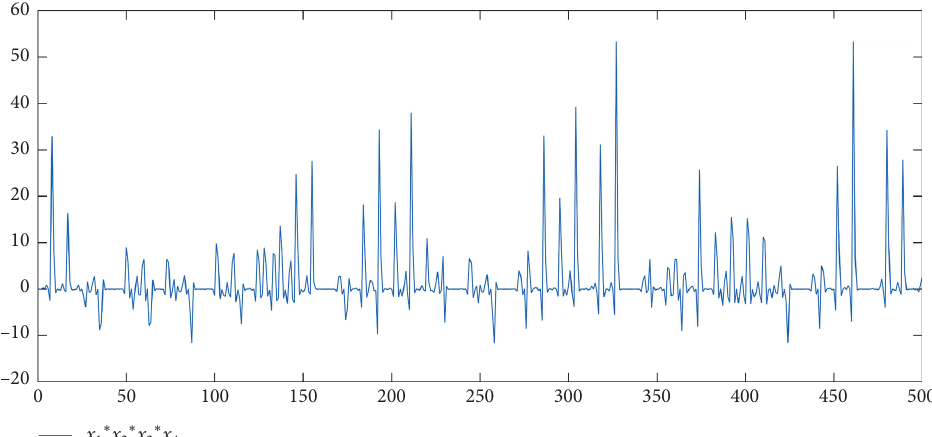
( 0 ) , x ( 0 ) , x ( 0 ) , x ( 0 )) � ( 0 . 1 , 0 . 1 , 0 . 1 , 0 . 1 ) and parameter values a � 1.4, b � 3, 1 2 3 4